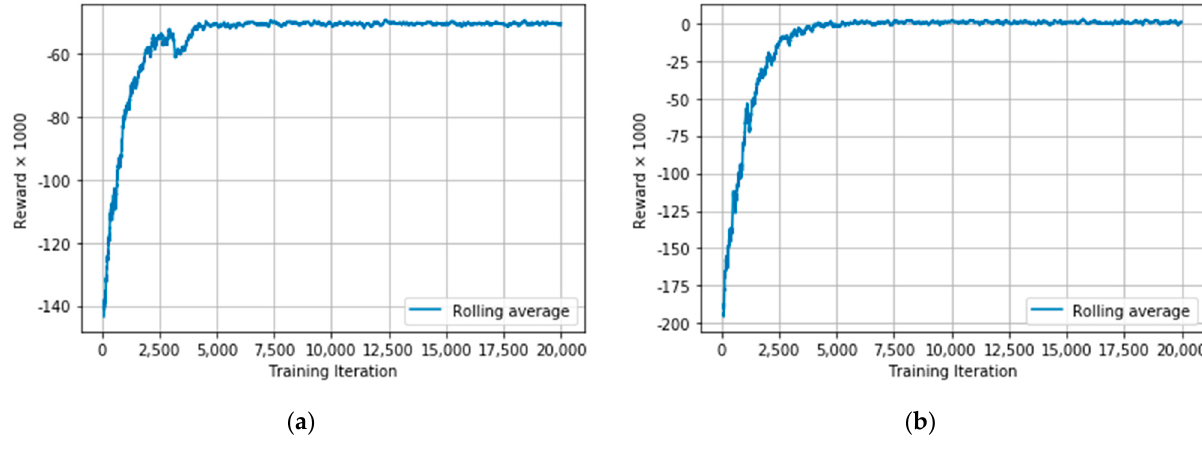
Figure 3. Training curve showing reward convergences for episode number 0 to 20,000; ( a ) trading algorithm ( b ) non- trading algorithm.